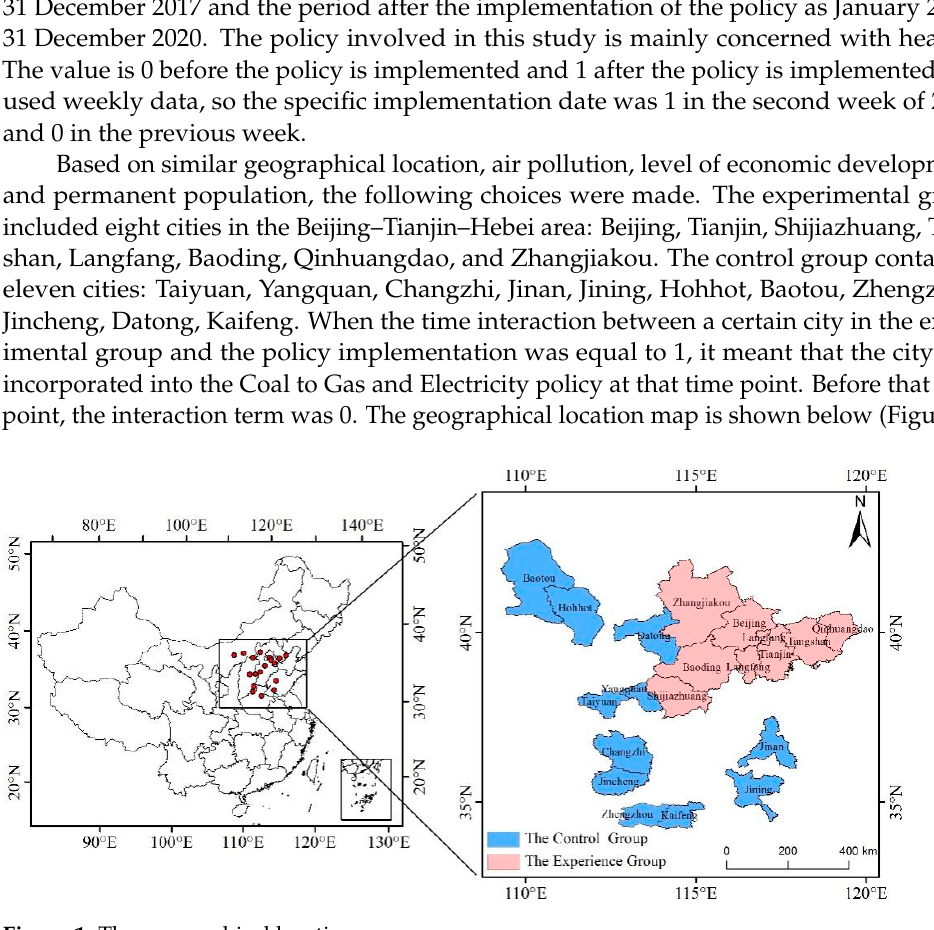
Figure 1. The geographical location map.